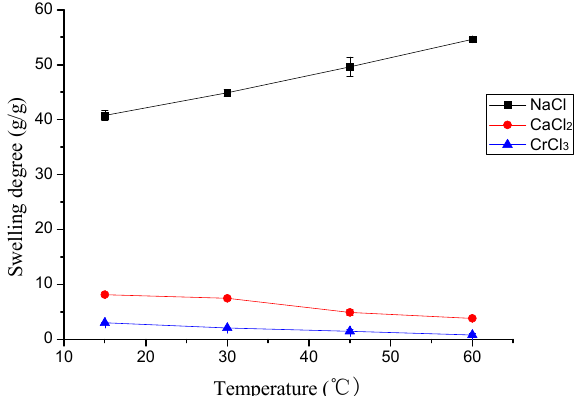
Figure 4. The effect of temperature on the swelling study of metal ions.